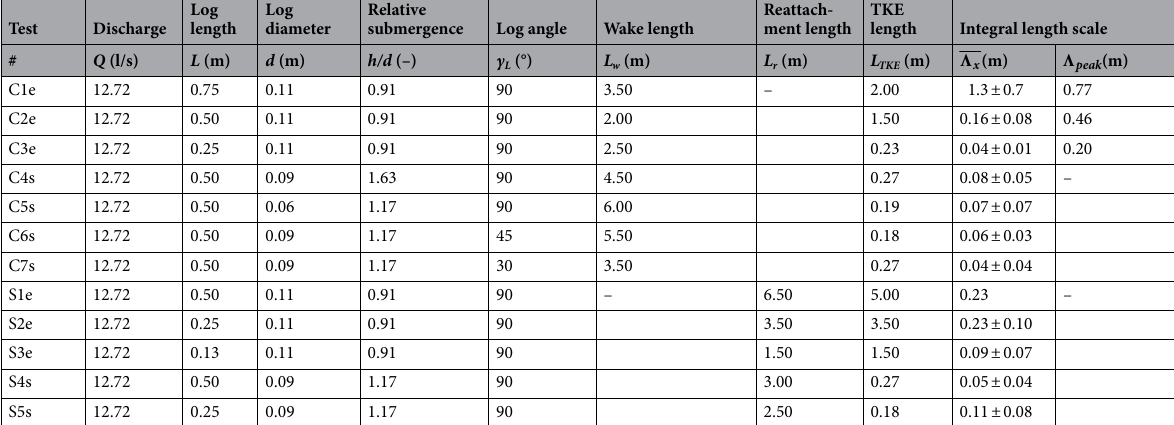
Table 1. Test program with flow depth h = 0.10 m and cross-sectional average velocity U = 0.10 m/s (C = log at center, S = log at side, e = emergent, s = submerged). The measured wake length L w and reattachment length L r exhibit a consistent uncertainty of Ο ( L ) due to measurement spacing. Longitudinally averaged (cid:31) x with standard deviation (except for S1e, which is a single measurement point). For cases with a VS (C1e–C3e), the peak integral length scale (cid:31) peak is also listed.